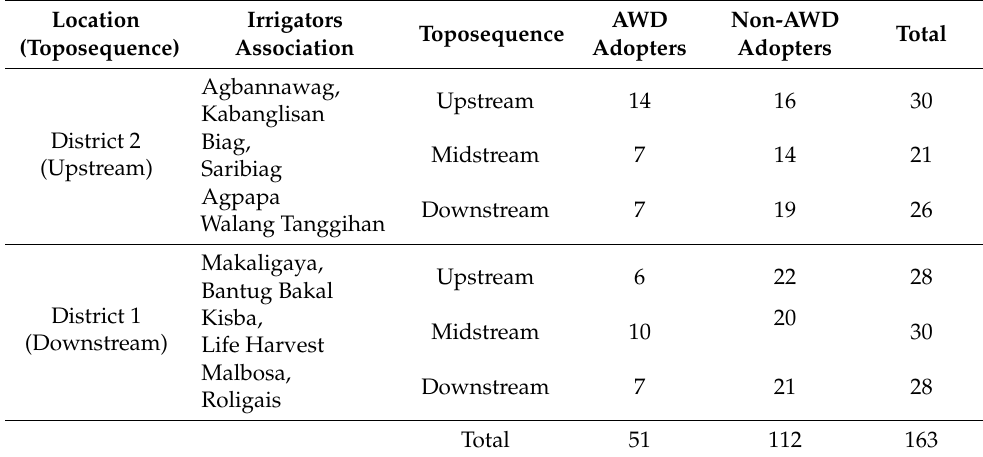
Table 1. Distribution of respondents in district 1 and 2 under different